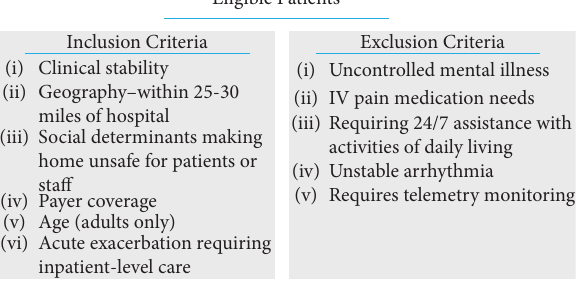
Figure 1: Advanced care at home patient eligibility